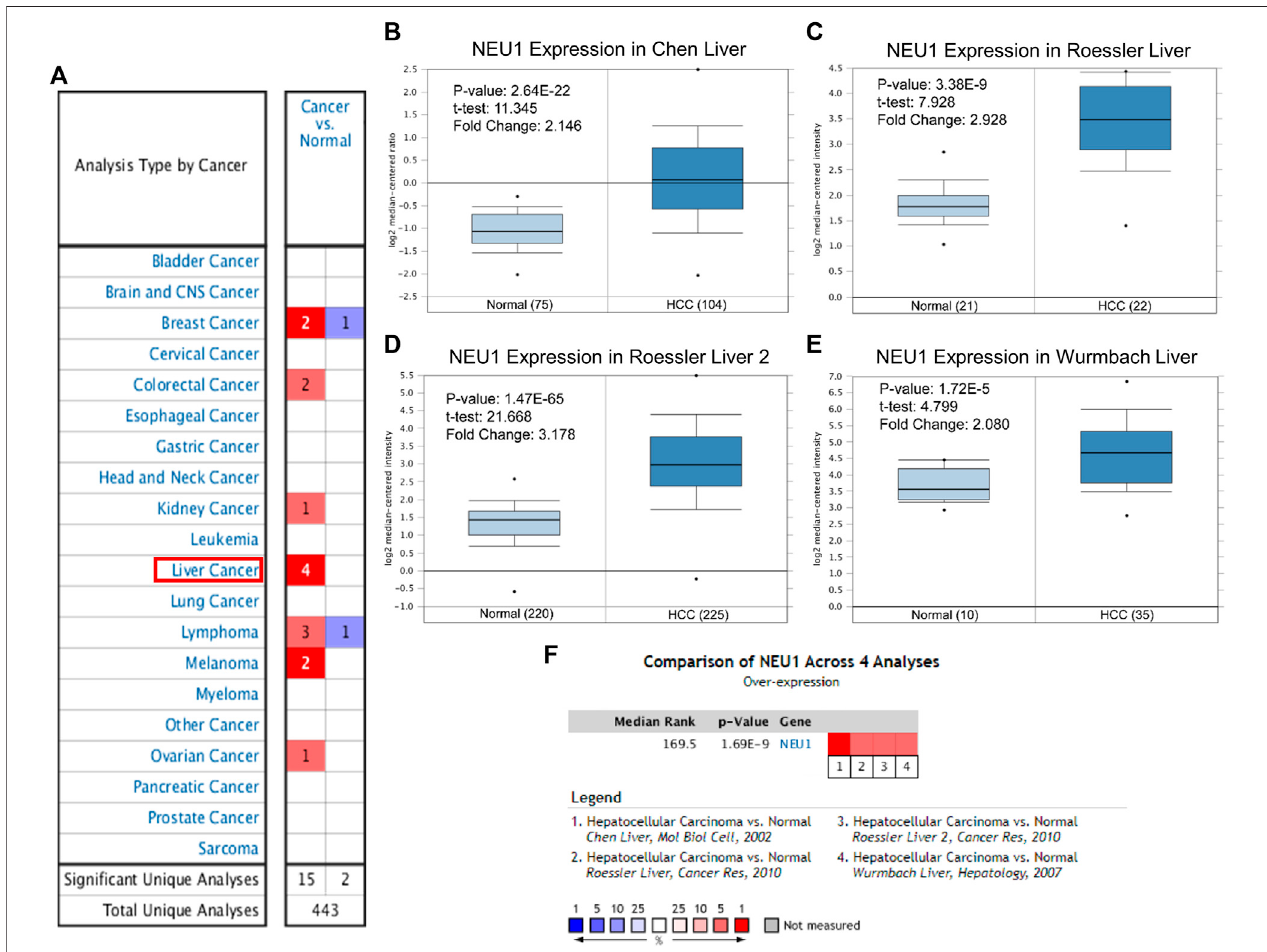
FIGURE 1 | The mRNA expression levels of NEU1 in multiple cancers and HCC based on ONCOMINE database (A) The mRNA expression pattern of NEU1 in various cancer types. Red color and blue color respectively indicate high and low expression. The number in each box represents the number of datasets that ful fi ll the threshold (B – E) The box-plots derived from four different datasets comparing NEU1 expression in normal (left) and HCC tissues (right) . HCC tissues showed higher NEU1 expression compared with normal liver tissues (F) A meta-analysis of NEU1 expression from four ONCOMINE datasets ( p (cid:1) 1.69E-9).